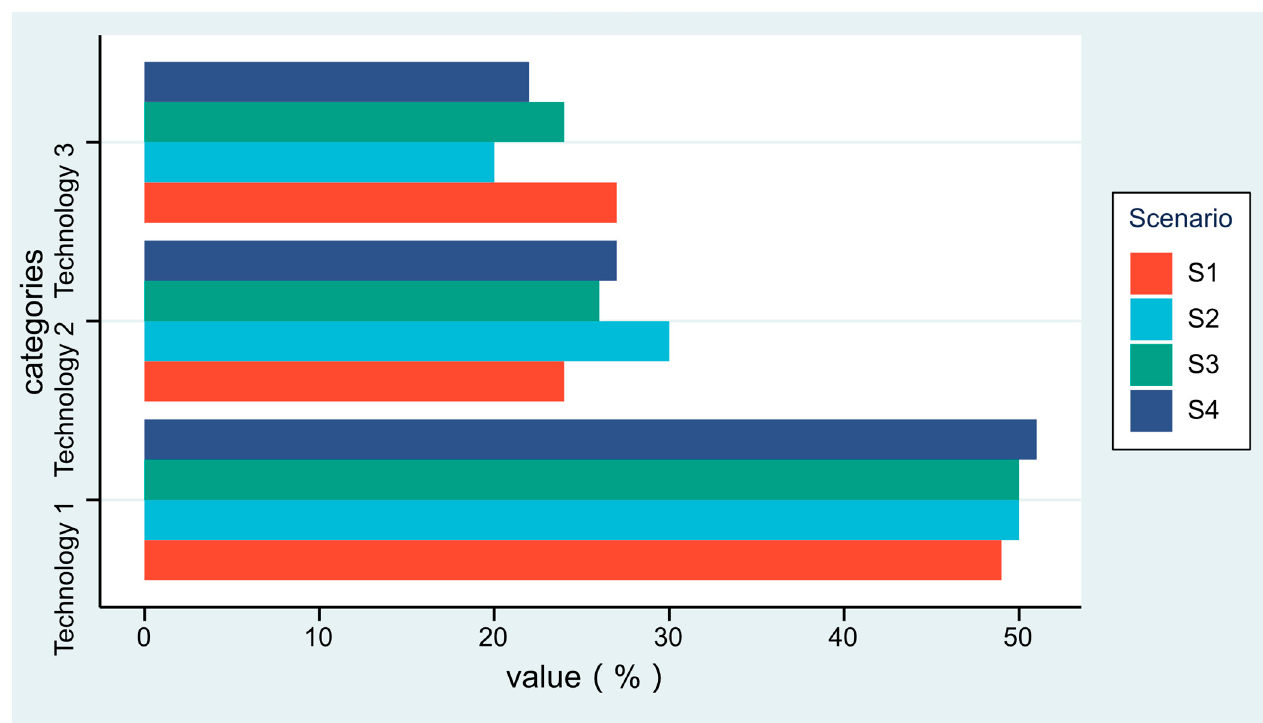
Figure 4. Water consumption of each part.